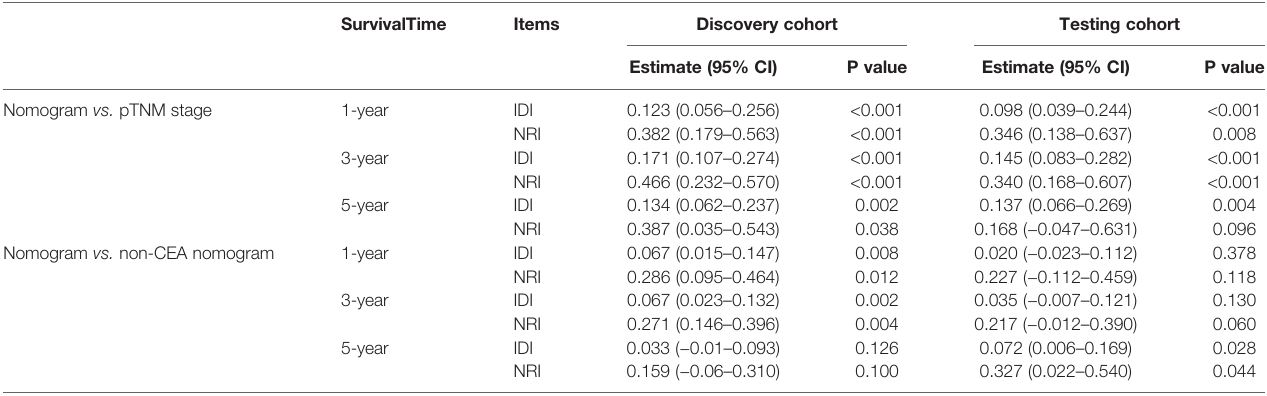
TABLE 3 | Improvement of the nomogram in predicting DFS compared with pTNM stage and non-CEA nomogram.